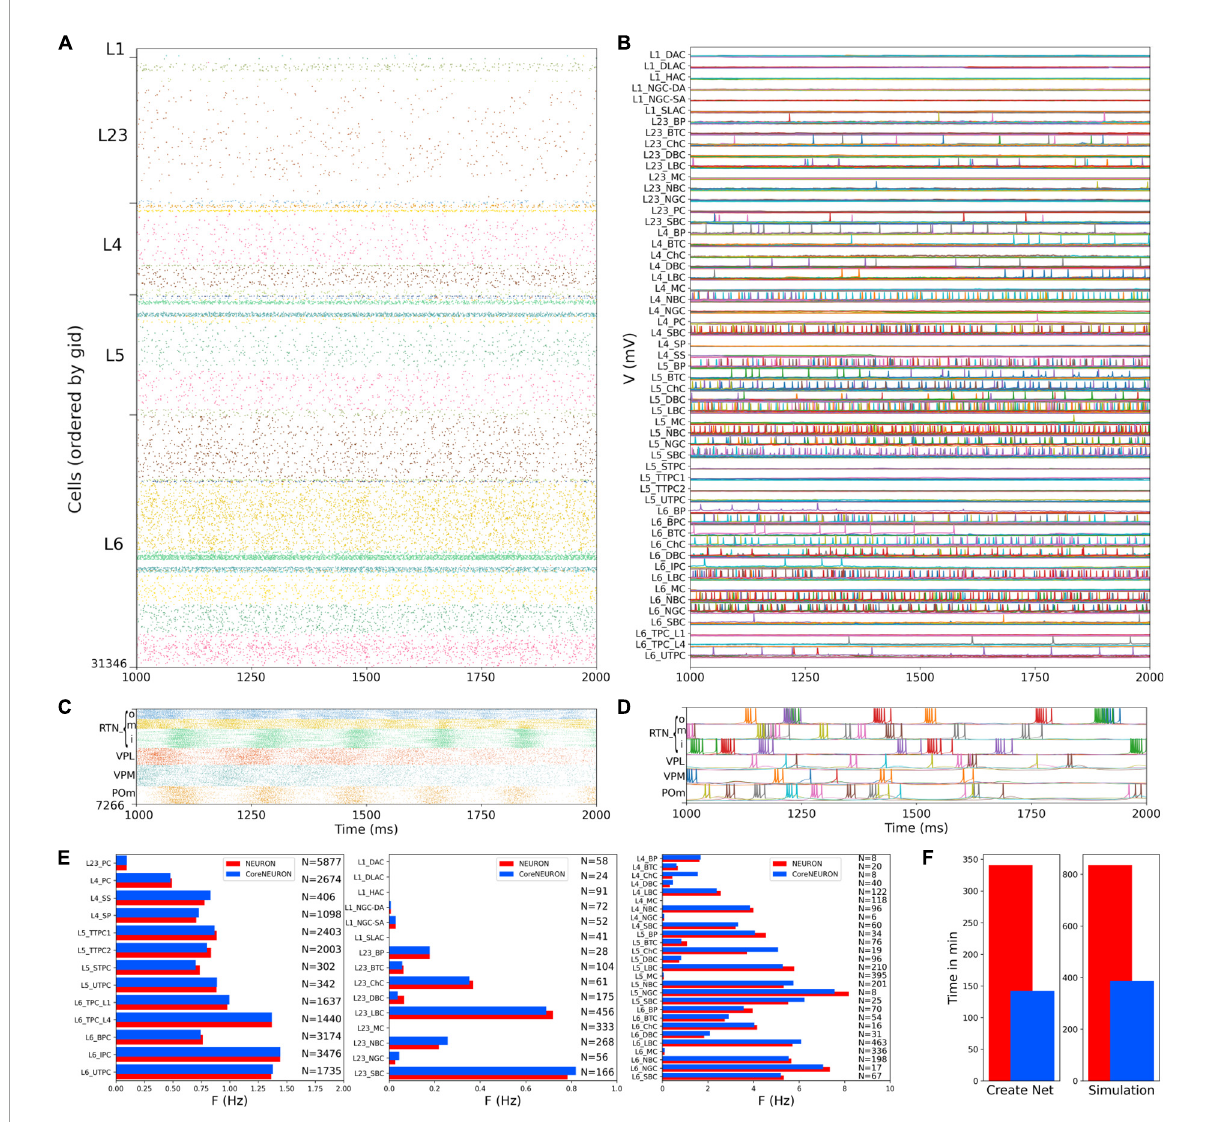
FIGURE5 NetPyNE S1 and thalamus circuit response to background inputs (spontaneous activity). (A) Spiking raster plot of the 31,346 cells in the S1 column during 1 s (the first second was omitted to allow the network to reach a steady state). (B) Example voltage traces for each of the 207 me-types grouped by rows into their respective 55 m-types (same time period as raster plot). (C) Spiking raster plot of the 7,266 thalamic neurons during 1 s showing intrinsic oscillations. (D) Example voltage traces for each of the 6 thalamic populations. (E) Mean firing rates of each of the 55 m-types for NEURON (red) vs. CoreNEURON (blue). (F) Comparison of the time required to create the network and run the simulation on a 40-core Google Cloud virtual machine using NEURON (red) or CoreNEURON